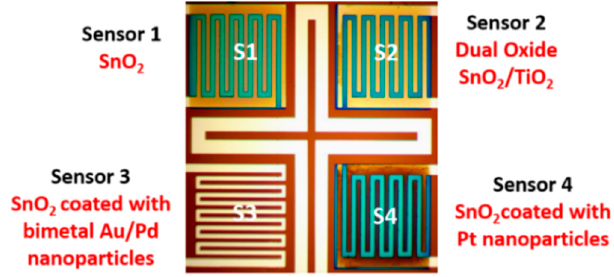
Figure 2. Materials used in the integrated detector. Table 1. Sensor structure and composition as deposited.